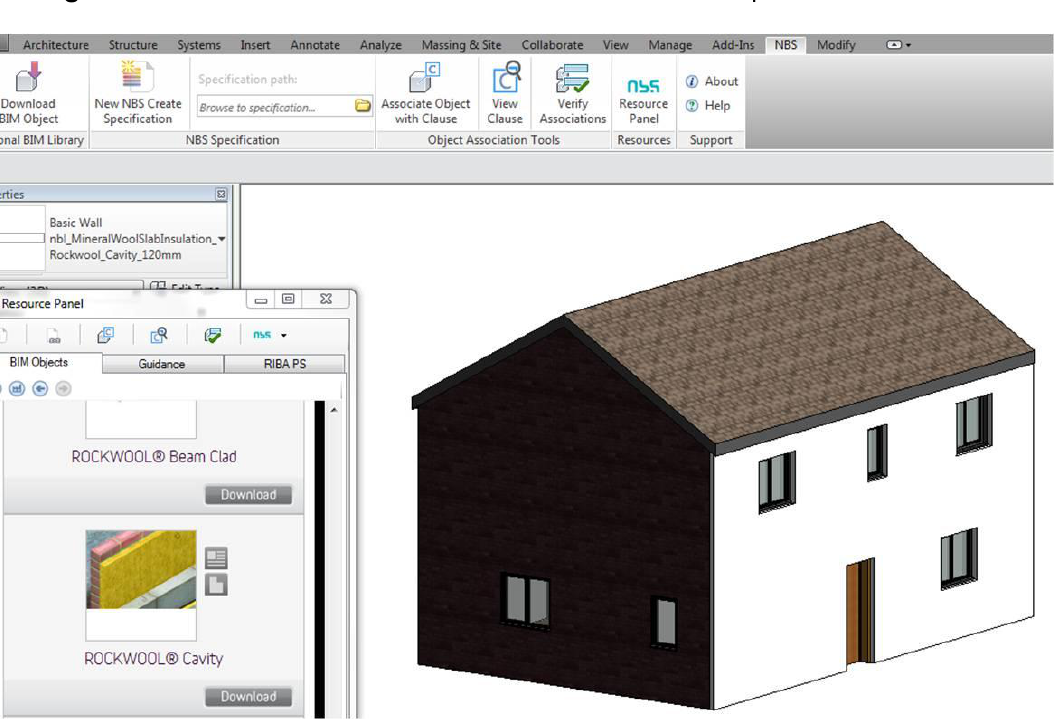
Figure 6. External wall insulation demonstration in